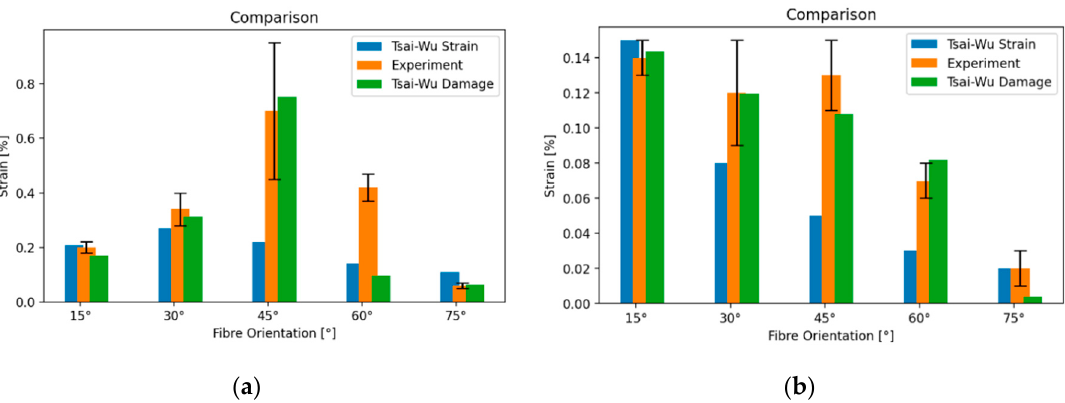
Figure 15. Comparison of the failure strain values between the tensile test and the predicted values from the damage-based and strain-based Tsai-Wu failure criterion for ( a ) C/C–SiC and ( b ) WHIPOX™.